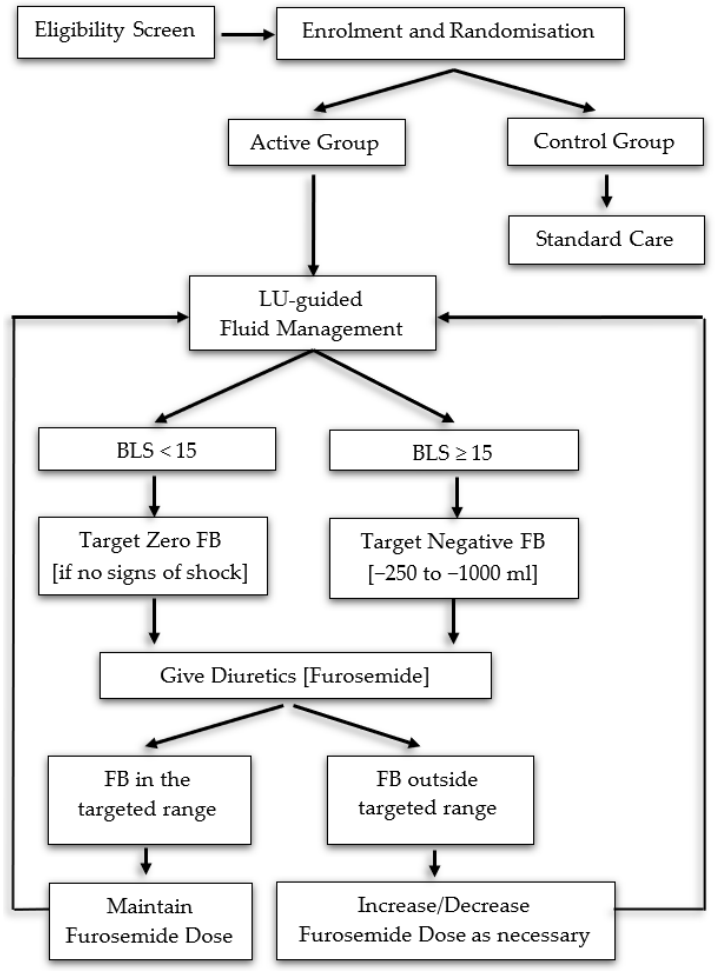
Figure 2. Trial algorithm.